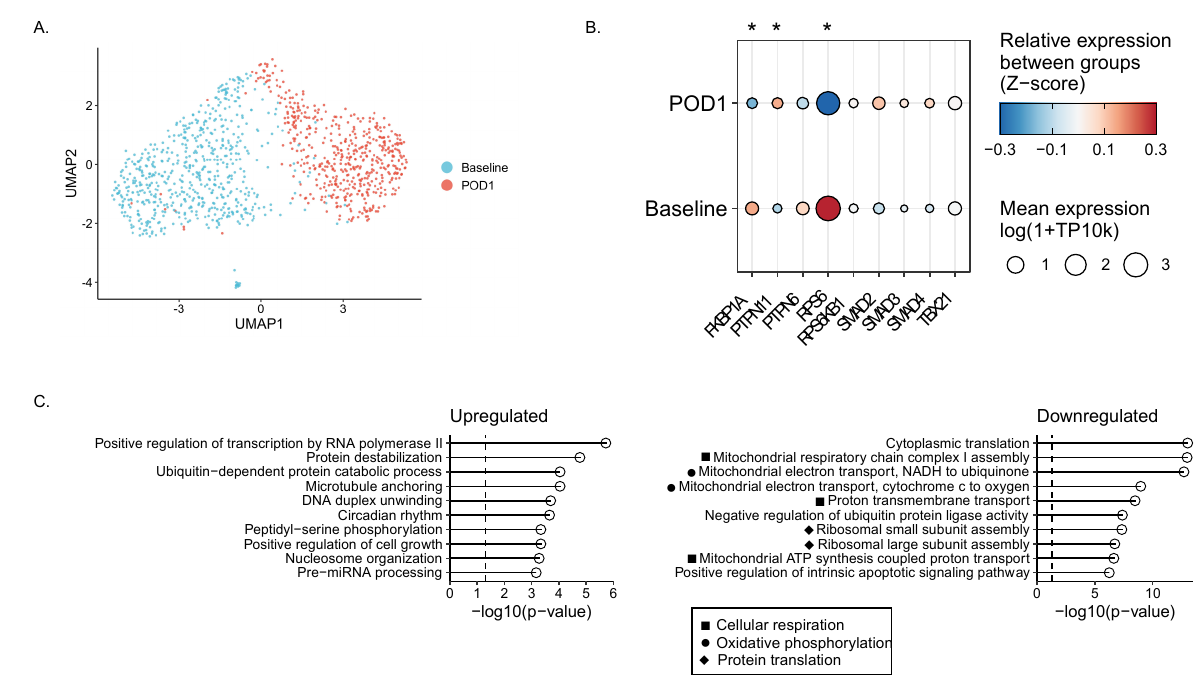
Figure 5. NK cells exhibit dysregulated metabolism and reduced mRNA translation on POD1. Six matched baseline and POD1 patient samples were collected and processed for multiplexed scRNA ‐ seq with the 10× Genomics Chromium technology. ( A ) UMAP plot of NK cell scRNA ‐ seq data at baseline (blue) and POD1 (red). Each point corresponds to a single cell. ( B ) Heat map of average expression levels of canonical and non ‐ canonical genes downstream of TGF ‐β genes in NK cells at baseline and POD1. TP10k = transcripts per 10 k transcripts. ( C ) Gene set enrichment analysis (GSEA), showing a list of the top significant upregulated and downregulated pathways. * p ≤ 0.05. TGF ‐β is thought to inhibit NK cell function via canonical and non ‐ canonical path ‐ ways. In the canonical pathway, transcription factor Smad2/3 is activated, translocates to